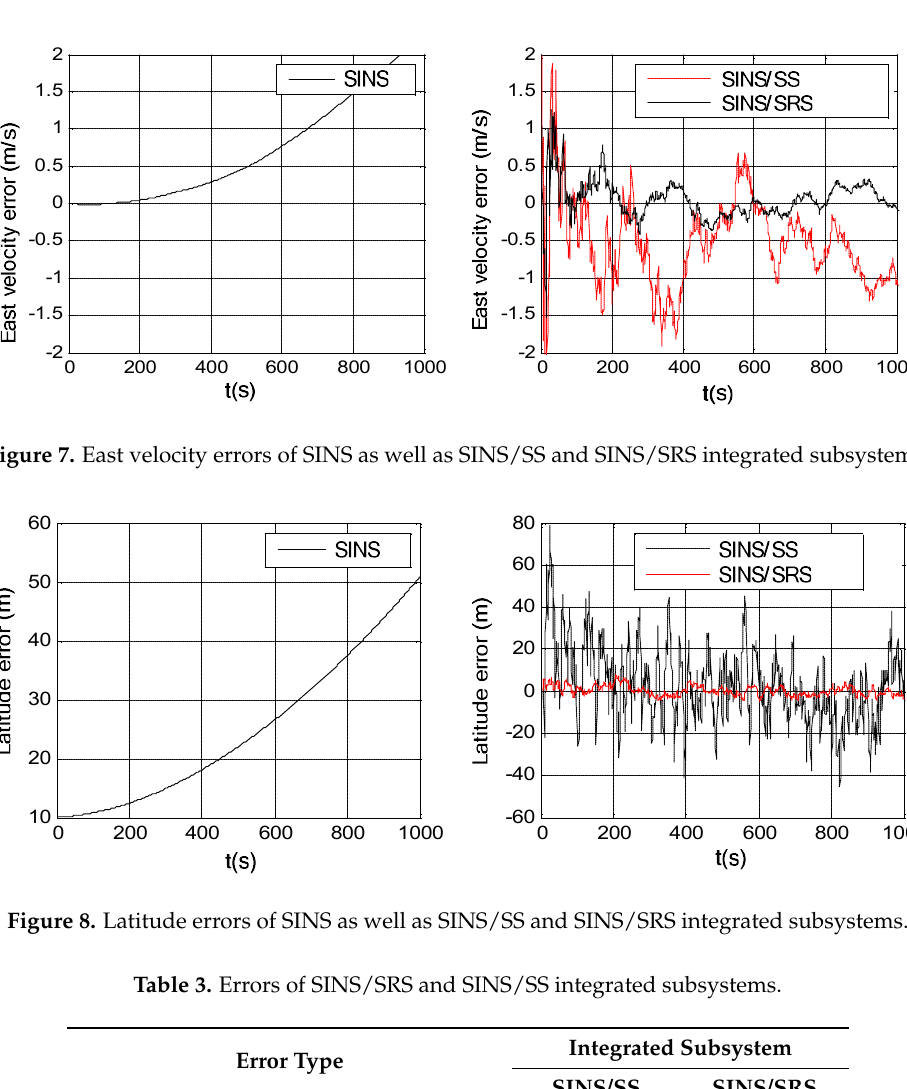
Figure 6. Course angle errors of SINS as well as SINS/SRS and SINS/SS integrated subsystems.